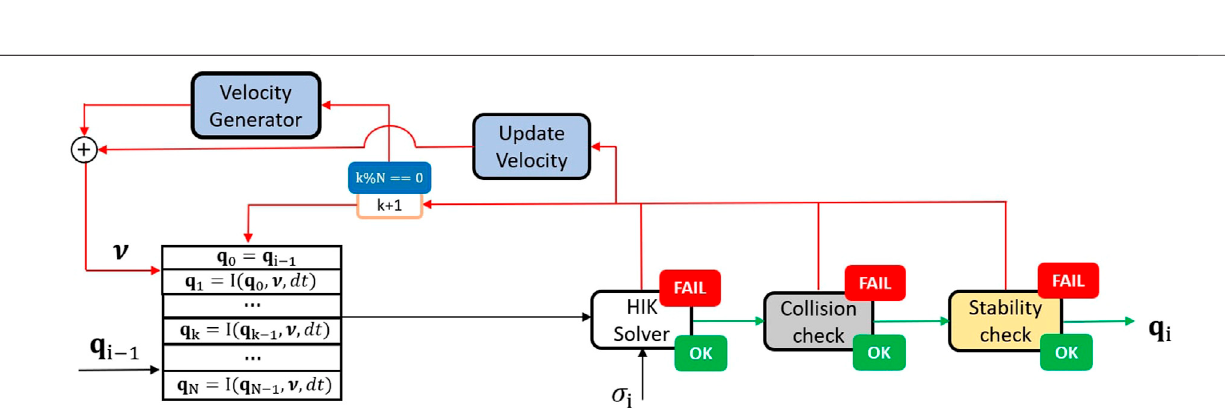
Frontiers in Robotics and AI |